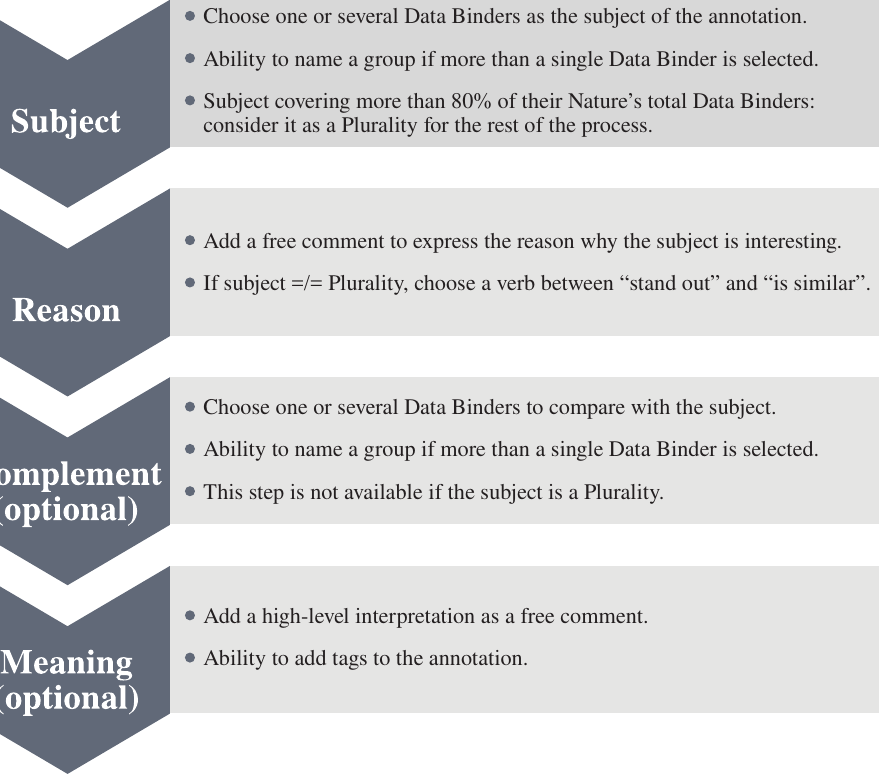
Figure 4. The annotation